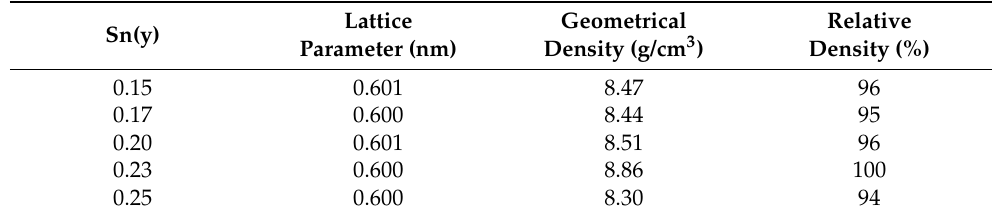
Table 4. The lattice parameter, geometrical density and relative density based on the